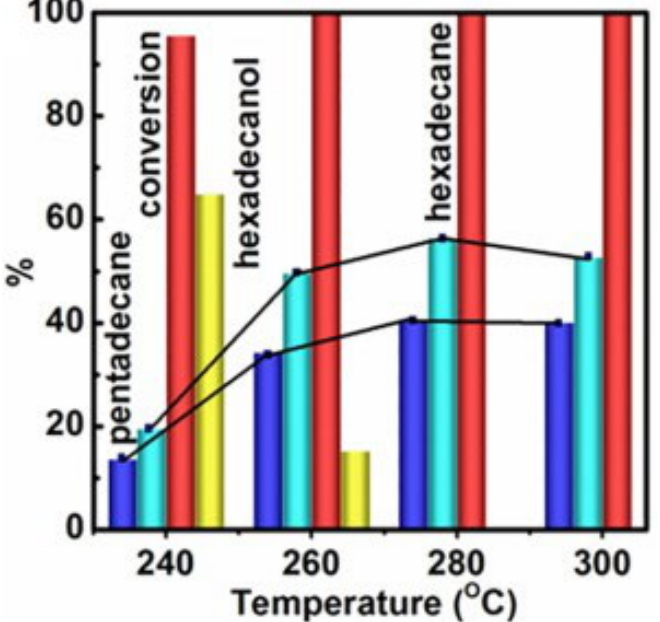
Figure 48. Conversion and selectivity for the main products as a function of reaction temperature over Ni/MoO 2 CT x catalyst (4 MPa H 2 , 240 min). Reprinted with permission from [85].